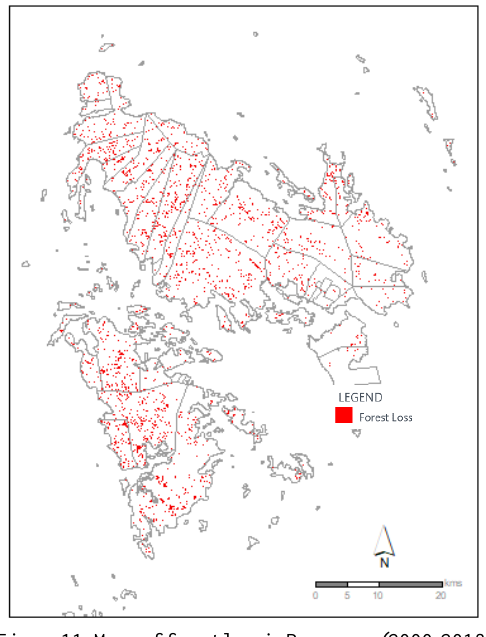
Figure 11. Map of forest loss in Busuanga (2000-2018) Figure 9. Comparison of chlorophyll-a concentration from MODIS and SeaWIFS Looking at the map of forest loss (Figure 11), there was no concentrated area of loss. Patches of forest loss can be seen dispersed within the study area which indicates no concentrated massive development. Aside from using forest loss data, vegetation indices such as Normalized Difference Vegetation Index is a good gauge for land cover change. Based on the MODIS NDVI time series in Busuanga from 2001 to 2019, as shown in Figure 12, there is a decreasing general trend in NDVI values. This trend confirms the loss of forest cover in the